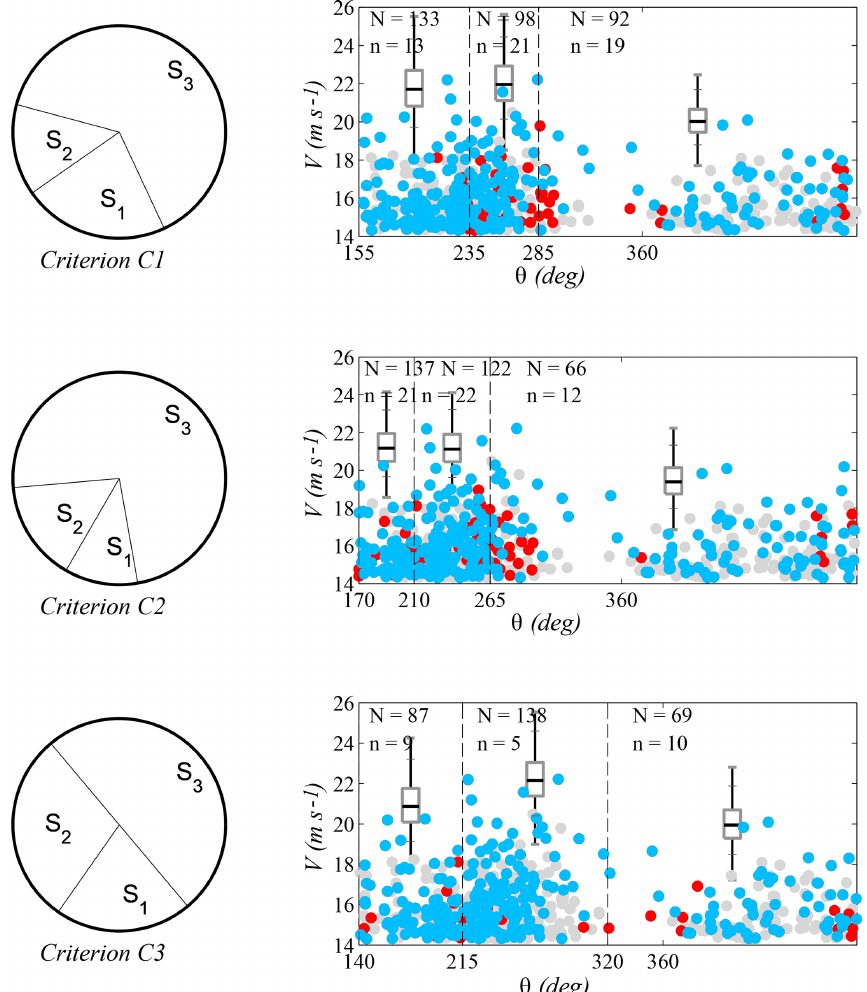
Figure 6. Sectors defined according to criteria 1–3.